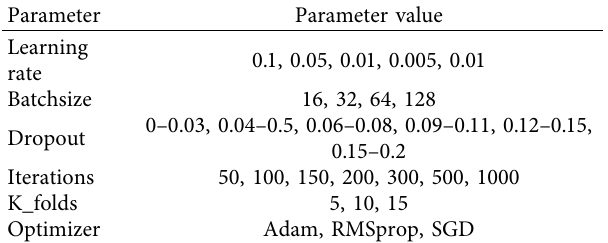
Table 5: Model parameter